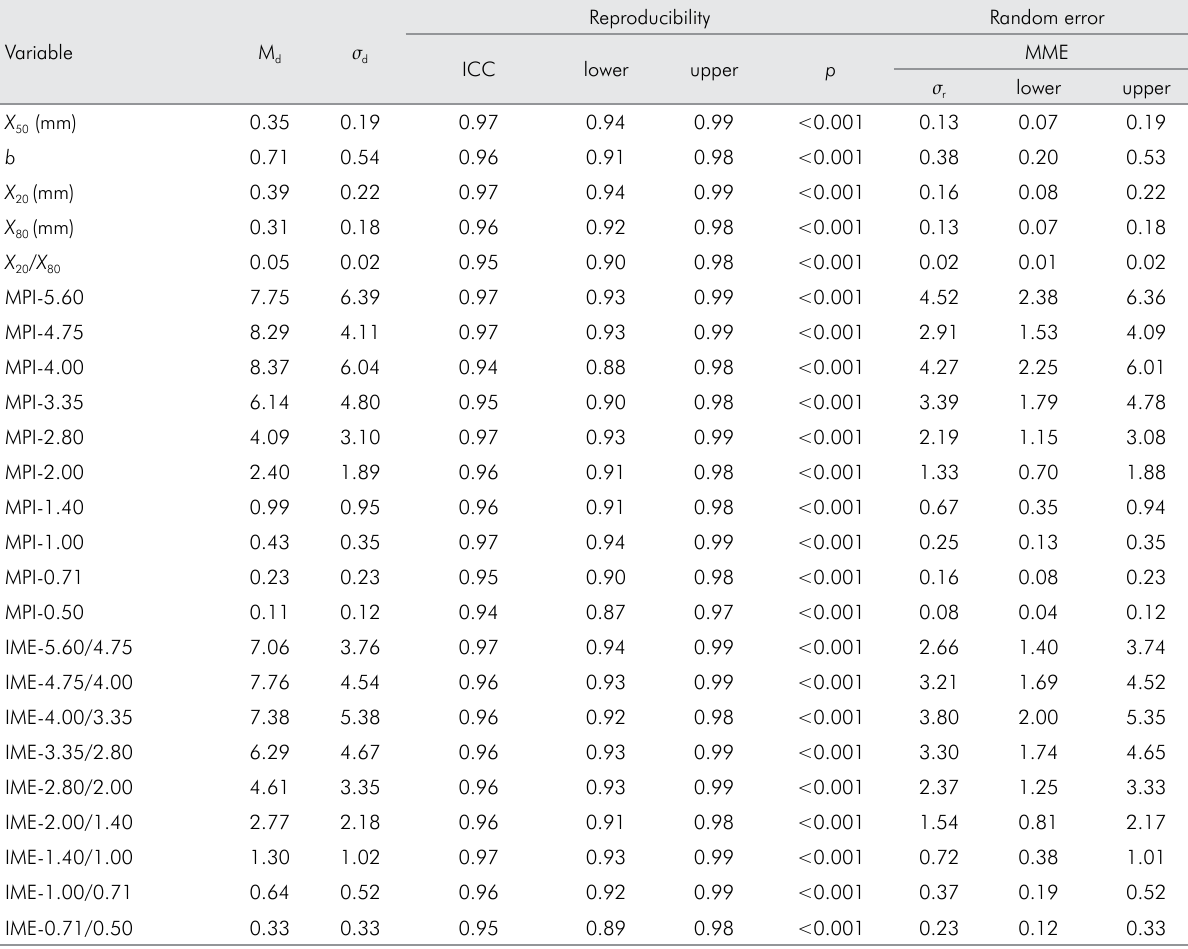
table 3. Inter-examiner reproducibility and random error in average means of absolute differences, according to the multiple sieve method (n =